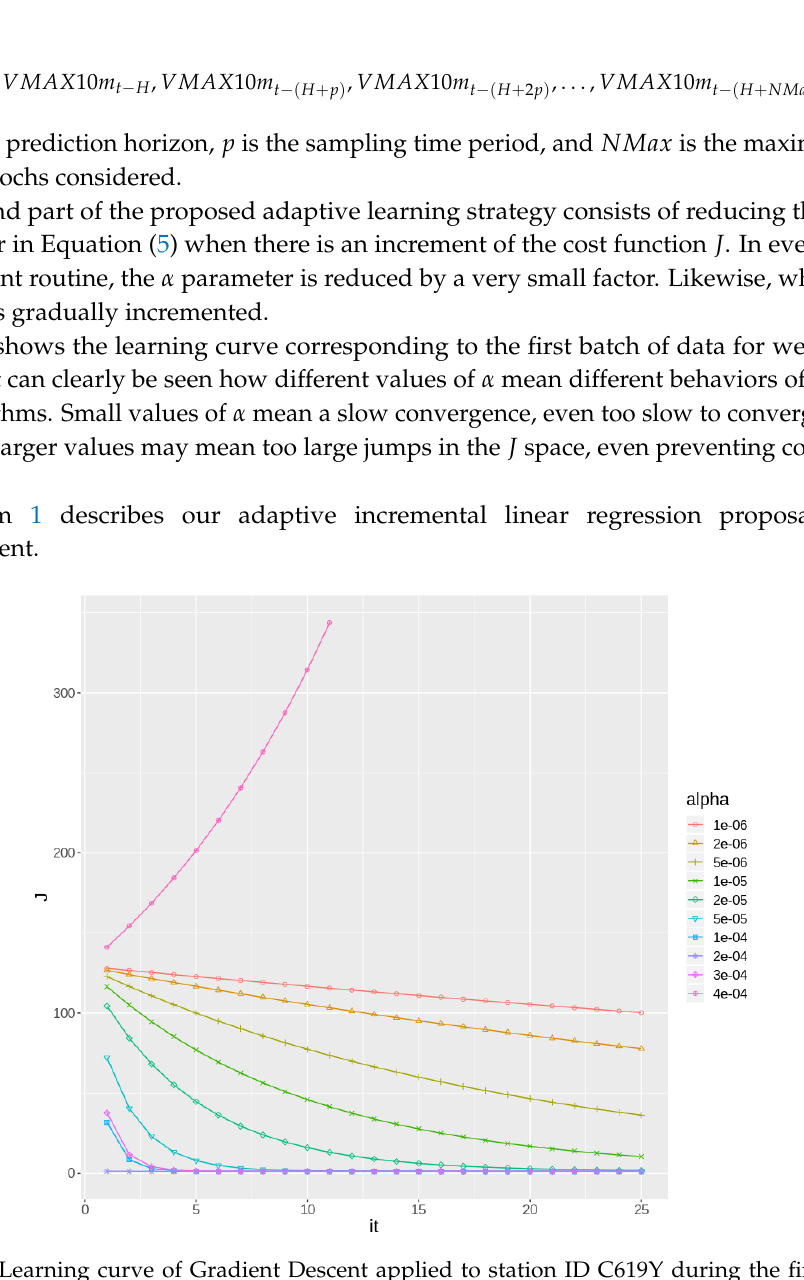
Figure 4. Learning curve of Gradient Descent applied to station ID C619Y during the first batch, varying α